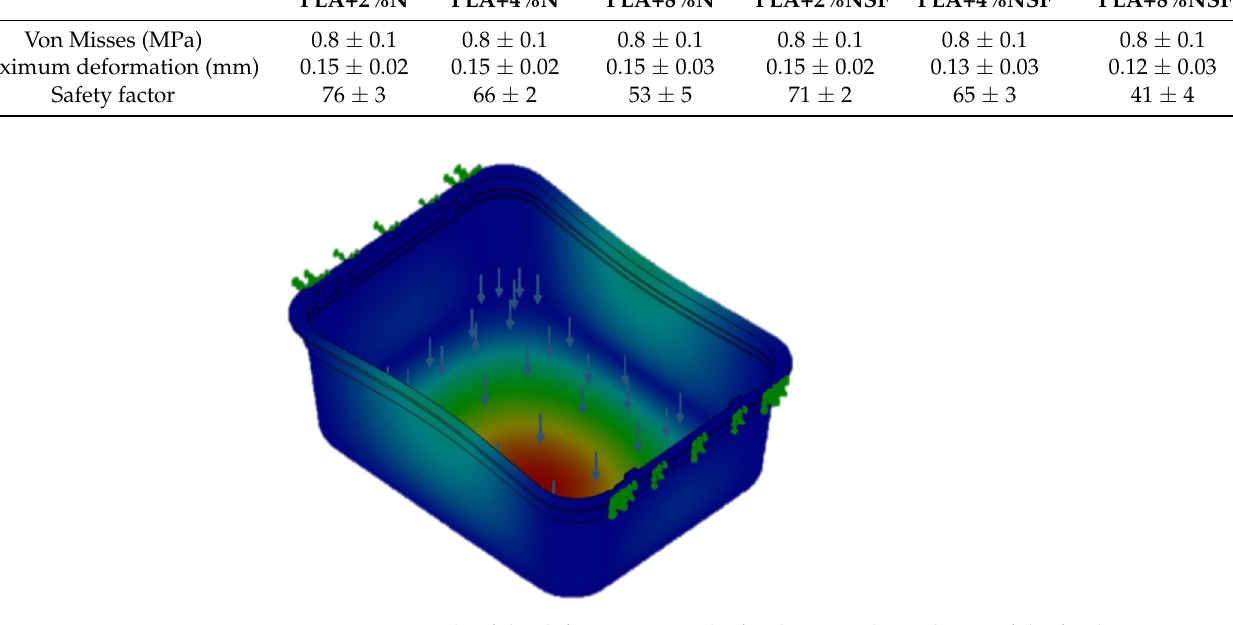
Table 9. Results for the second simulation using the new nanocomposites.